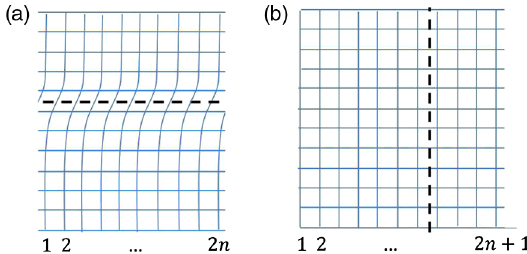
FIG. 5. Illustration of two lattice configurations to detect the topological nematic states. (a) A torus with a kink along the dashed line such that all points above the dashed line are translated by one lattice spacing in the x direction relative to a regular lattice model, and with an even number of sites in the x direction. (b) A regular lattice with an odd number of sites in the x direction. In both cases, a periodic boundary condition is imposed on both directions. For both configurations, the ( mml ) topological nematic state of type (1,0) has a reduced ground-state degeneracy of j m þ l j instead of the degeneracy of j m 2 (cid:3) l 2 j on a torus with an even number of sites in the x